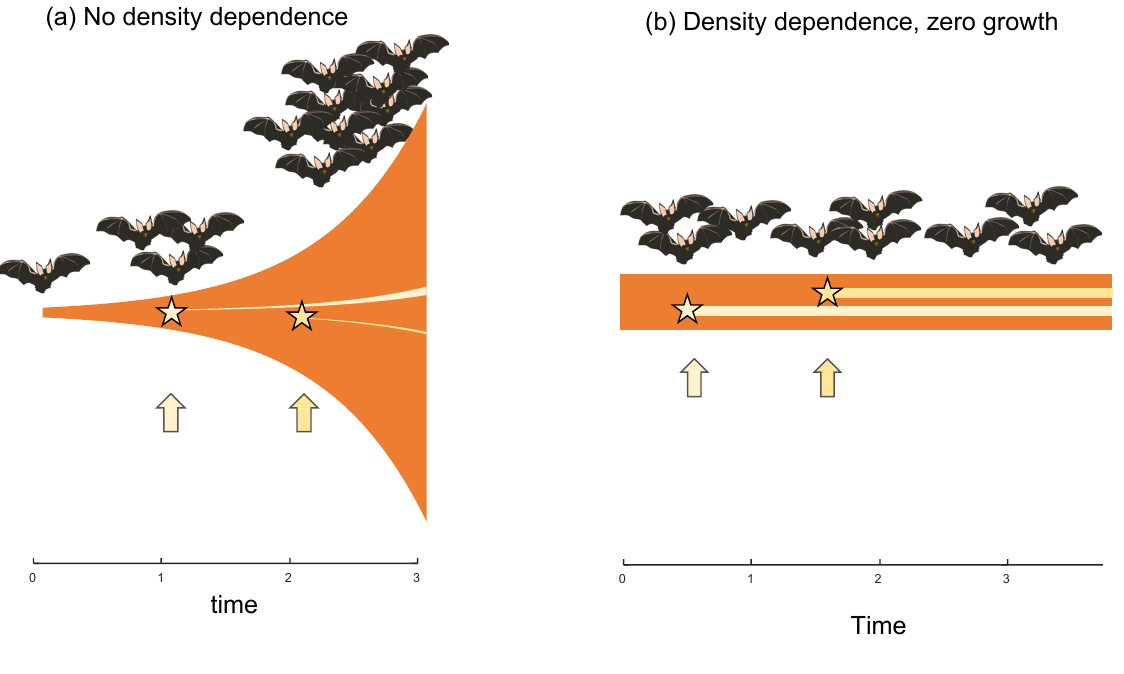
Figure 2 – A visualization of the difference between placing offspring early or late in an exponentially growing population (on the left) or in a stable population (on the right). In a growing population, the late placed offspring will be a smaller fraction of the future population than the early placed offspring. In a stationary population, there is no such discounting of early vs. late placed